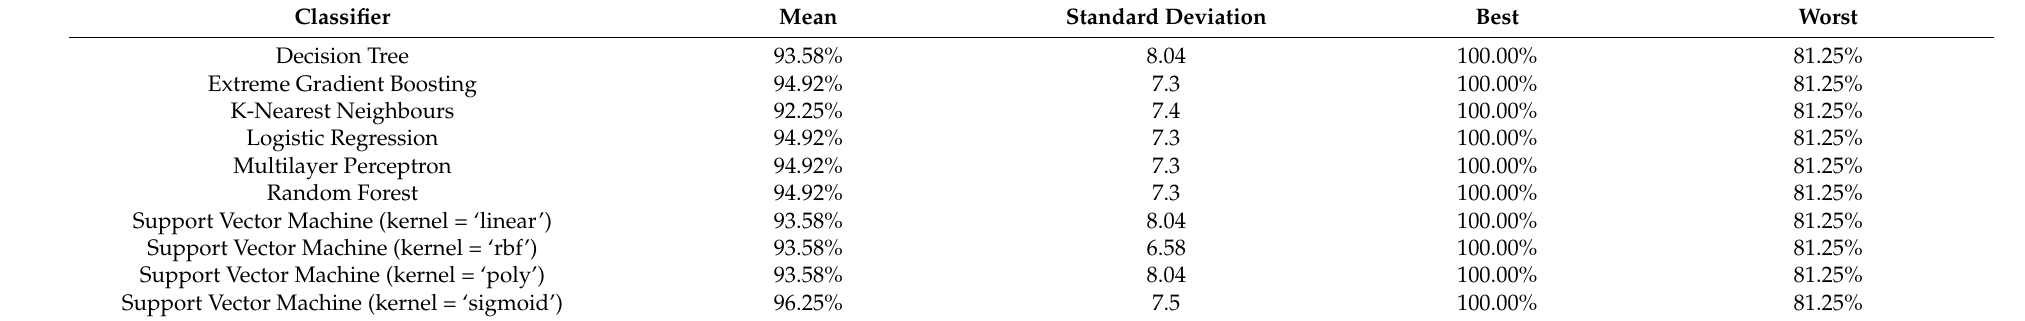
Table 4. Mean, best, and worst accuracy and standard deviation of classifiers for 2 different types of risks with the K-fold Cross-Validation method (k =